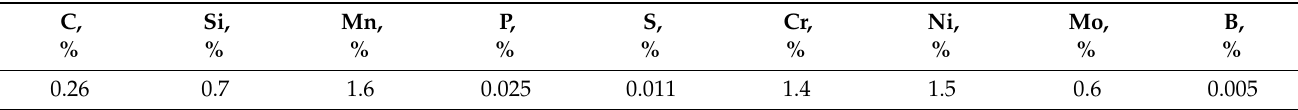
Table 2. Chemical composition of Hardox 450 steel